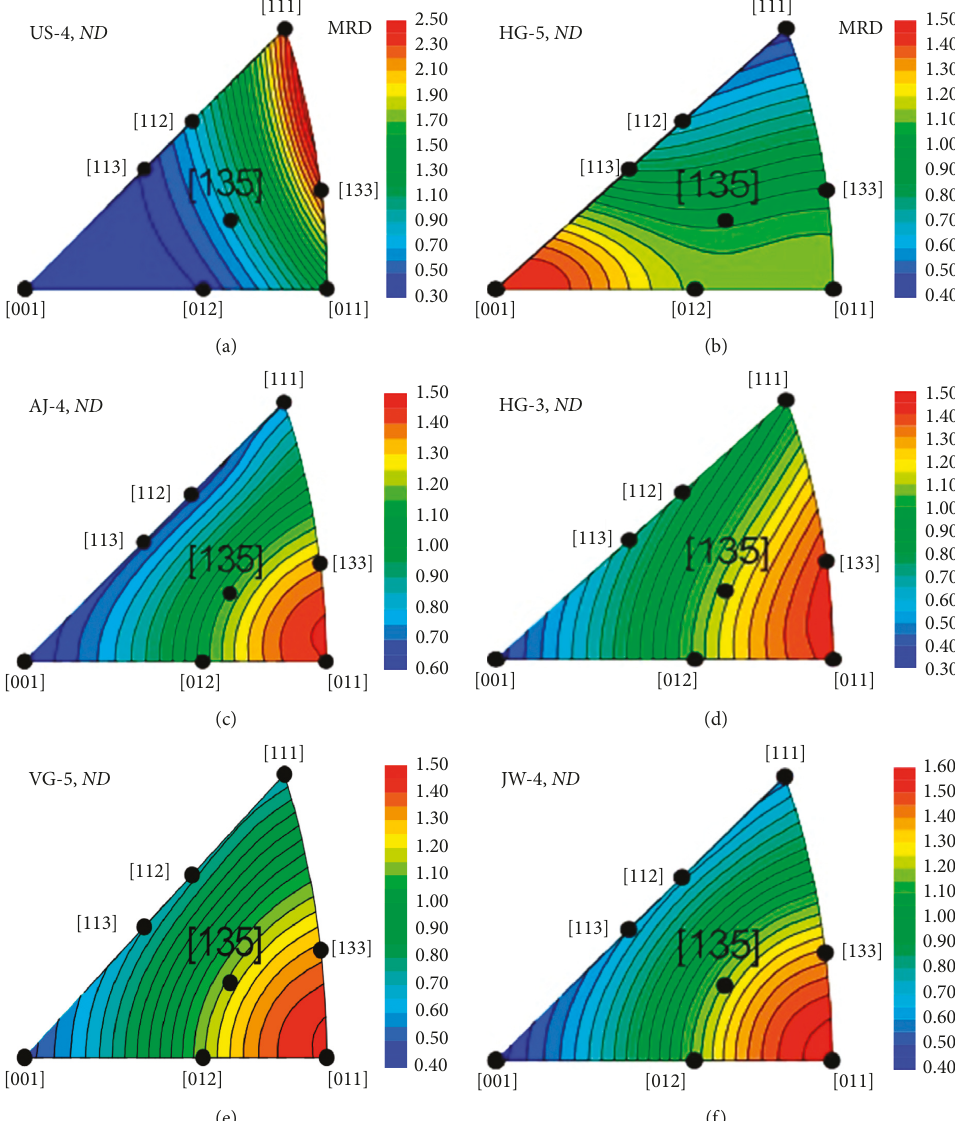
Figure 12: From top left: inverse pole figures for an unstruck, cast flan; a struck coin of Herod the Great (HG-5), whose figure is characteristic of a recrystallization (annealing); four coins exhibiting the expected compression figures (AJ-4, HG-5, VG-5, and JW-4) from striking. Although JW-4 was annealed or struck while hot, the compression figure suggests it was only partially annealed or was struck again subsequently. Contours are in units of multiples of a random